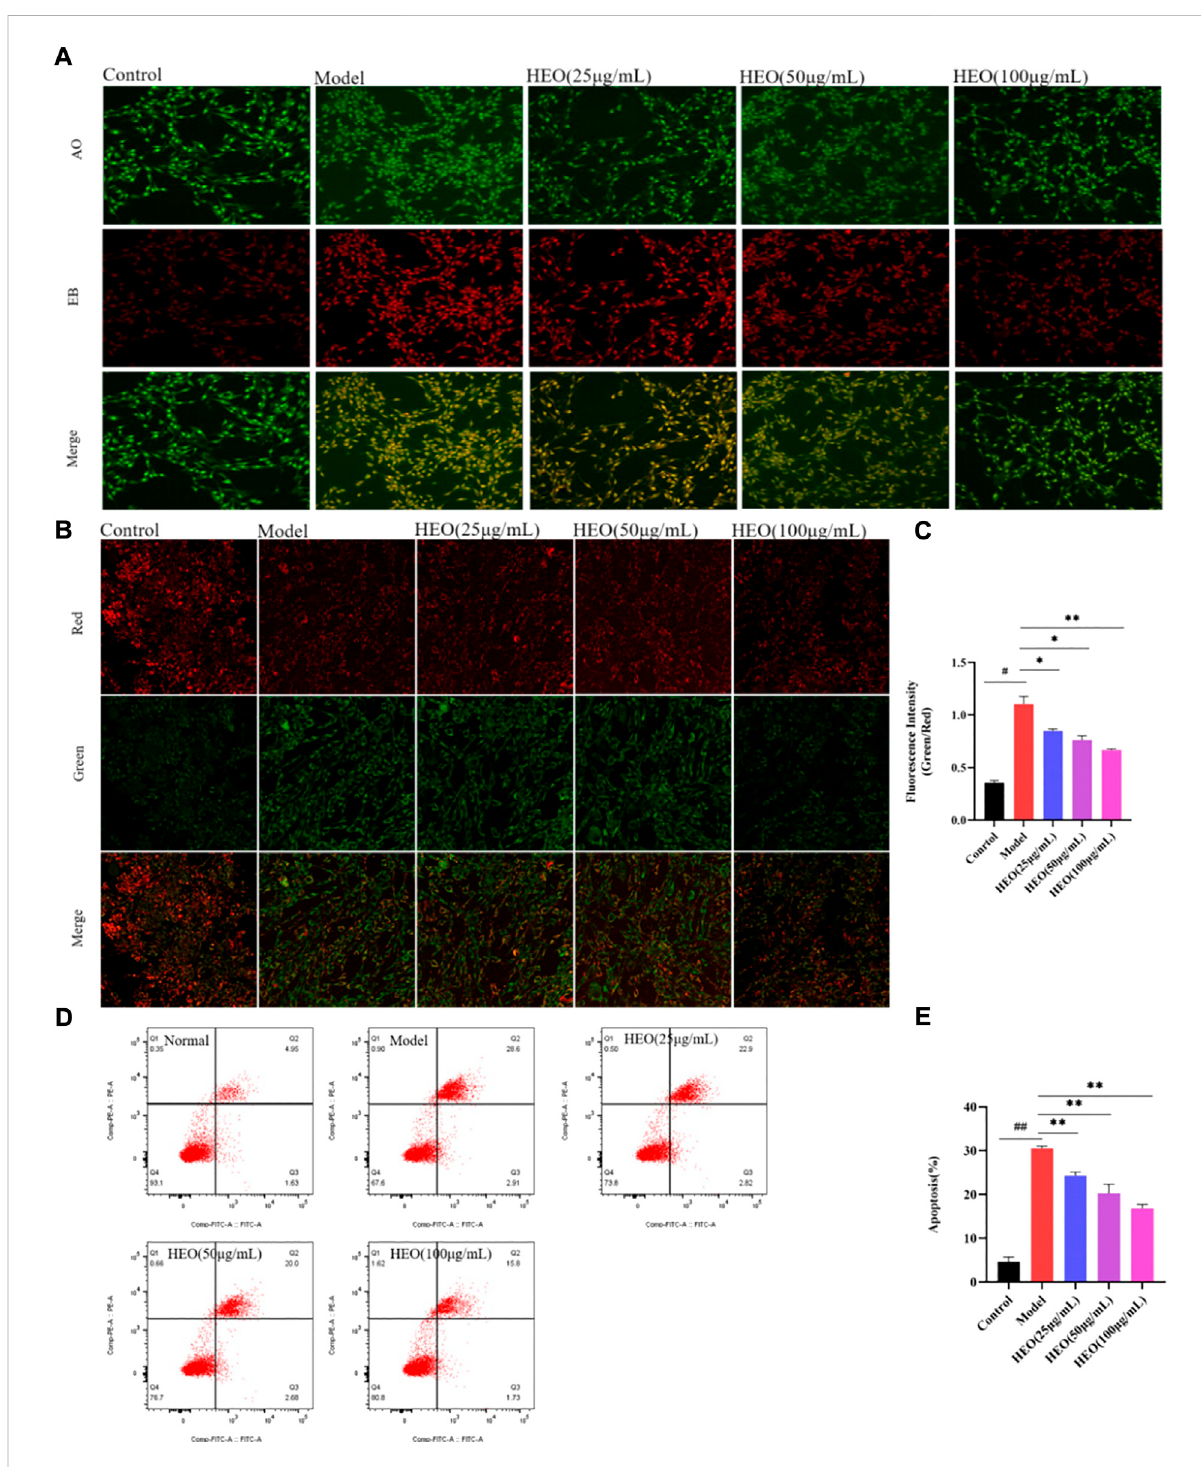
FIGURE 10 HEO suppresses apoptosis in CORT-treated PC12 cells. AO-EB staining (×20) (A) ; Effects of HEO on the ΔΨ m in PC12 cells (×40) (B – C) ; Apoptotic assay by fl ow cytometry of PC12 cells (D – E) . The values were represented as the mean ± SEM ( n = 3). # p < 0.05 and ## p < 0.05 vs the control group; * p < 0.05 and ** p < 0.01 vs the model